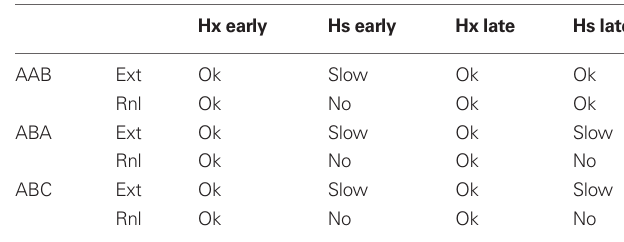
Table 3 | Effects of hippocampal ablation (Hx) or suppression (Hs) during extinction and renewal testing on extinction (Ext) and renewal (rnl) in FrAT (suppression continues during renewal